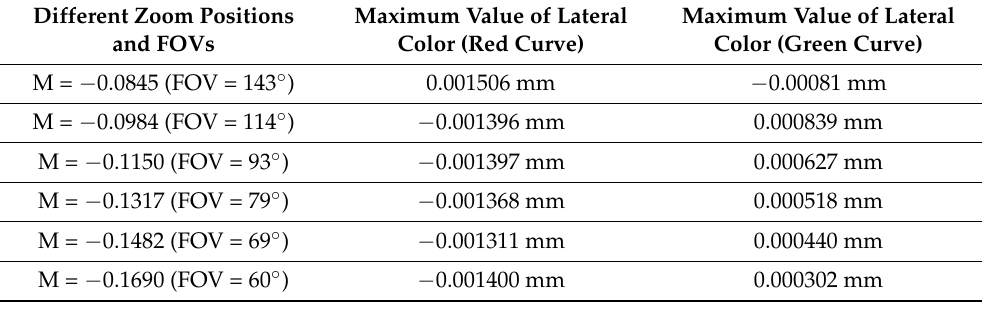
Table 4. Comparison of lateral chromatic aberrations at different magnification positions.